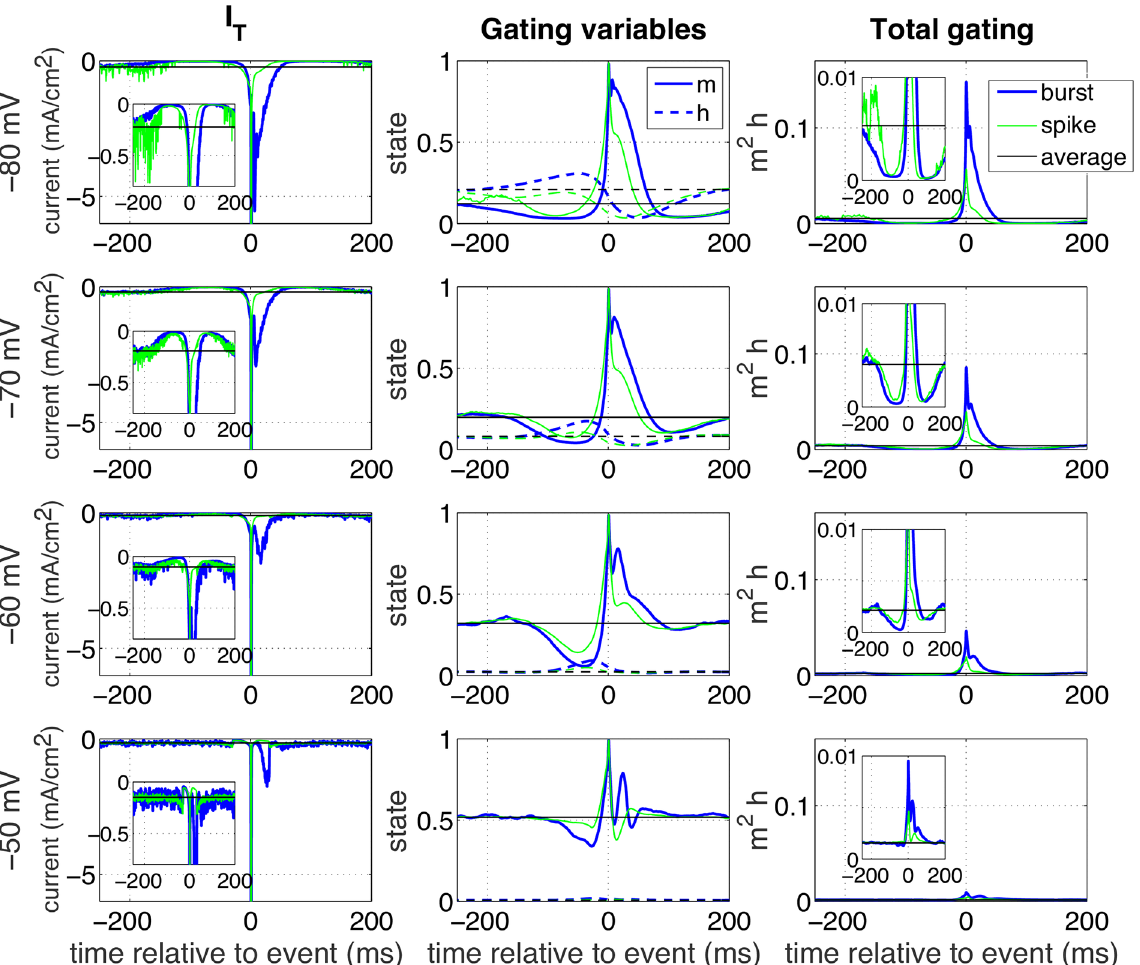
Fig 11. Event-triggered T-type calcium current. Event-triggered T-type calcium currents were calculated for the model (first column) comparable to the experimental ETAs in Fig 6; t = 0 indicates the peak of the (first) spike. Rows indicate the four different membrane states; blue traces indicate the current when a burst was induced, while green traces depict the situation for an isolated spike. The horizontal black line gives the mean value in the steady state condition. The inset zooms in around the time of initiation. The second column depicts the gating variables m (solid) and h (dashed) that underly the current using the same color code. The third column illustrates the total gating (the product m 2 h ) that underlies the current. particularly slow for isolated spikes. Moreover, the coherence (Fig 4) shows that at hyperpolar- ized states single spikes do not show the broadband phase locking at the peak of an oscillation (phase = 0 rad), but only low-frequency phase locking, with a later phase for higher frequen- cies. The model allows us to directly test this hypothesis. To this aim we calculated the ‘event- triggered T-current’ (Fig 11, left column). The T-type calcium current was implemented with three gating variables, two identical activation gates m and one inactivation gate h . We calcu- lated the ETA for these activation gates (Fig 11, second column) and also for their product m 2 h (denoted by ‘total gating’, Fig 11, third column) for all four membrane states (rows). The biggest difference between bursts (blue traces) and spikes (green traces) can be seen after the (first) spike: The T-current (first column) and the total gating (third column) are higher for bursts (blue traces) than for spikes (green traces). The inactivation gate (middle col- umn, dashed lines) is further opened before bursts than before spikes. As expected, there is a